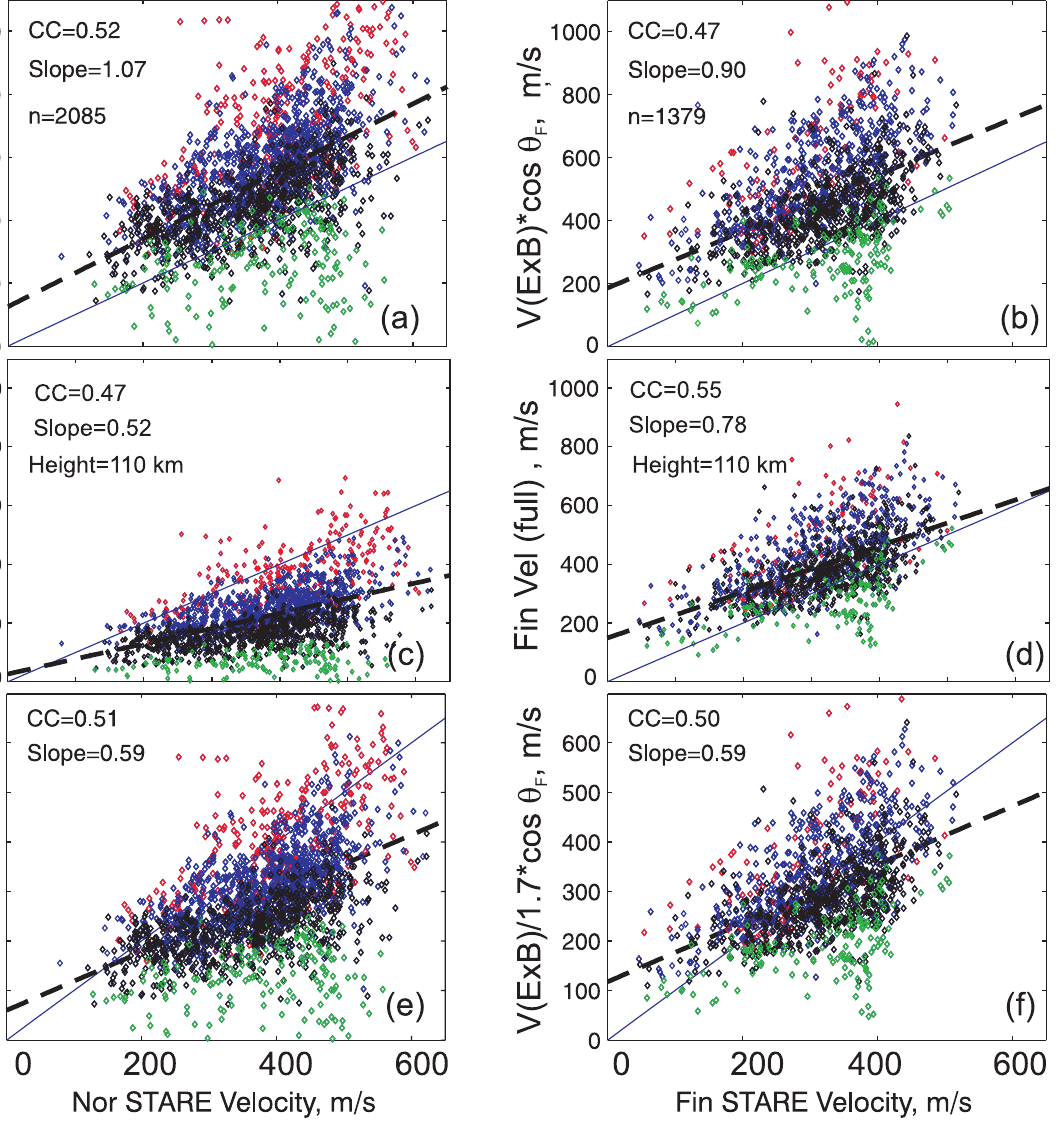
Fig. 8. The same as in Fig. 4 but for predictions based on the assumption that the irregularity phase velocity is the line-of-sight component of the E × B electron drift, panels (a) and (b) , on the assumption that the observed velocity is described by the linear fluid theory applied to the height of 110km, panels (c) and (d) , and on the assumption that the observed velocity is the l-o-s E × B component scaled down because of the aspect angle effect and echo reception from various heights (Uspensky et al., 2004), panels (e) and (f) .